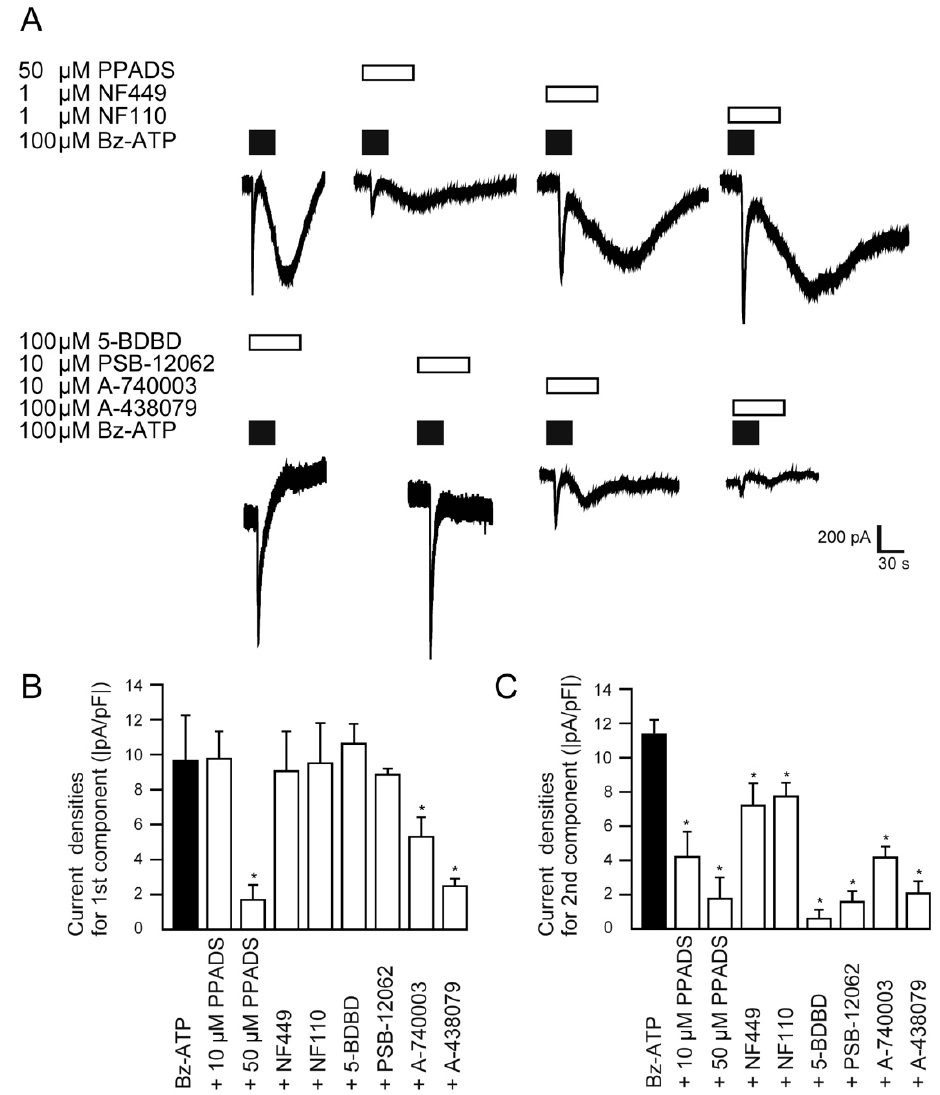
Figure 4. Pharmacological identification of the first and second component of Bz-ATP-induced currents. ( A ) Representative traces of Bz-ATP-induced currents (upper black boxes; 100 µ M) with or without non-specific P2X receptor antagonists, P2X 1 -, -P2X 3 -, P2X 4 - and P2X 7 -receptor antagonists (upper open boxes: 50 µ M PPADS, 1 µ M NF449, 1 µ M NF100, 100 µ M 5-BDBD, 10 µ M PSB-12062, 10 µ M A-740003, or 100 µ M A-438079). ( B , C ) Summary bar graphs show current densities of the first ( B ) and second components ( C ) of the Bz-ATP-induced biphasic inward currents with or without P2X receptor antagonists (see above). Each bar denotes the mean ± SD of five experiments. Statistically significant differences between columns are indicated by asterisks. * p < 0.05.